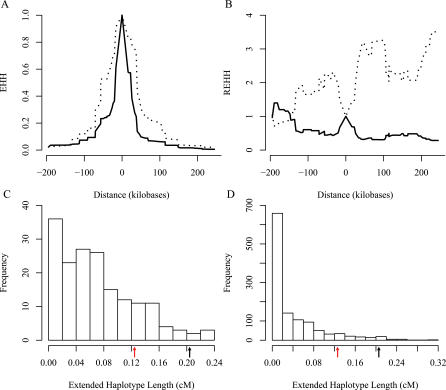
Impact of Deletion Size on EHH(A) EHH and (B) REHH values are shown for the insertion allele (solid line) and deletion allele (dotted line) in the combined JPT and CHB HapMap population. Distances are plotted based on the given SNP coordinates without accounting for the reduced size of the deletion haplotype. The extended haplotype length for the deletion variant is compared to an empirical distribution obtained for (C) SNP haplotype blocks and (D) individual SNPs. The comparison was made with SNPs or cores having a frequency between 0.35–0.40. The black arrow indicates the value obtained without correcting for the reduced size of the deletion haplotype while the red arrow indicates the true EHL value for the deletion.